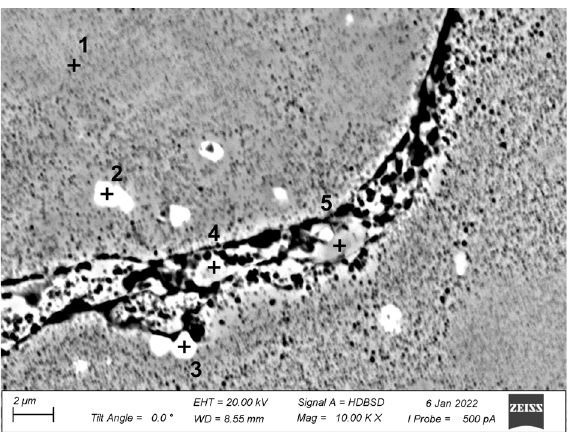
Figure 8. Backscatter electron image of a cracked grain boundary and its surroundings.